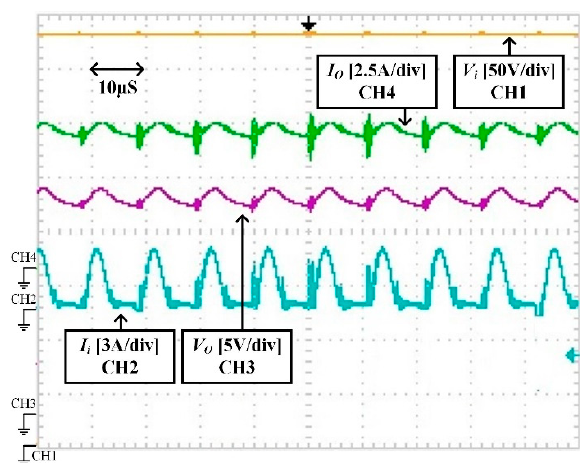
Figure 6. Photo of the implemented prototype. Electronics 2018 , 7 , x FOR PEER REVIEW